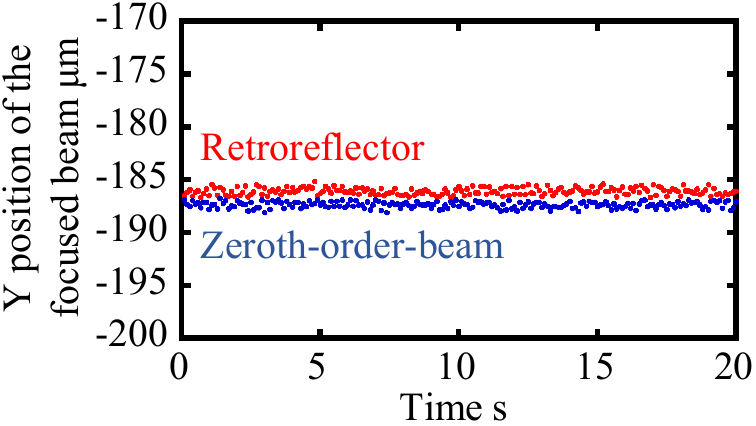
Figure 8. Y -position of the focused laser beam on the beam profiler during the alignment. After the verification of the angular misalignment α , the alignment of the single-mode fiber in the fiber detector unit was carried out while the angular position of the spindle was kept stationary at θ = 0 ◦ . Figure 9 shows the spectrum of the zeroth-order diffracted beam captured by the detector unit. The alignment of the single-mode fiber was carried out so that the total laser power to be detected by the detector unit became maximum while observing the spectrum of the captured laser beam. As can be seen in the figure, a non-uniform spectrum of the optical frequency comb laser was successfully observed.